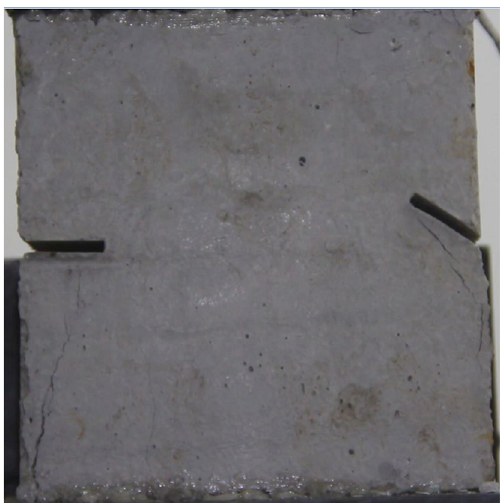
Figure 49. Photograph of a specimen showing tensile crack from the bottom surface caused by compression and anti-tensile wing crack appearing.